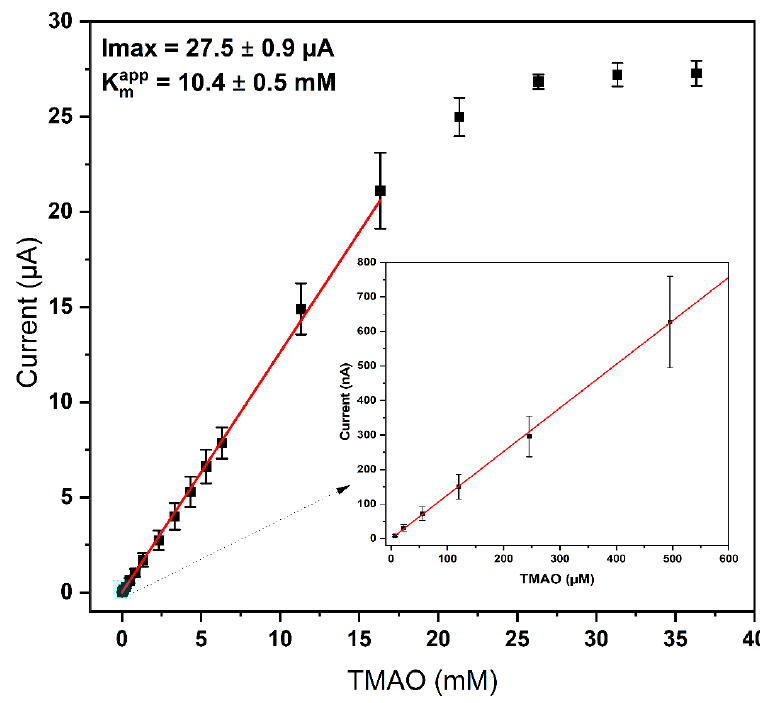
Figure 7. Graph of current response versus TMAO concentrations. Red line is the linear fit between 0.002 and 17 mM TMAO. The inset shows the range with low concentrations (2 µM – 600 µM). Measurements were performed in Sörensen buffer pH 7; 1 mM MV was used in each experiment; TorA (5.9 nmol/cm 2 ); GOD 10 U, Cat 1000 U, PVA 3% and glucose 3 mM. (n = 5 electrodes, 3 repetitions per concentration and electrode). Red line: Linear fit: Y = 1295.8X − 95.83; R-square = 0.999 (Range of Fitting = 0.002 – 16.3 mM, slope nA/mM) .